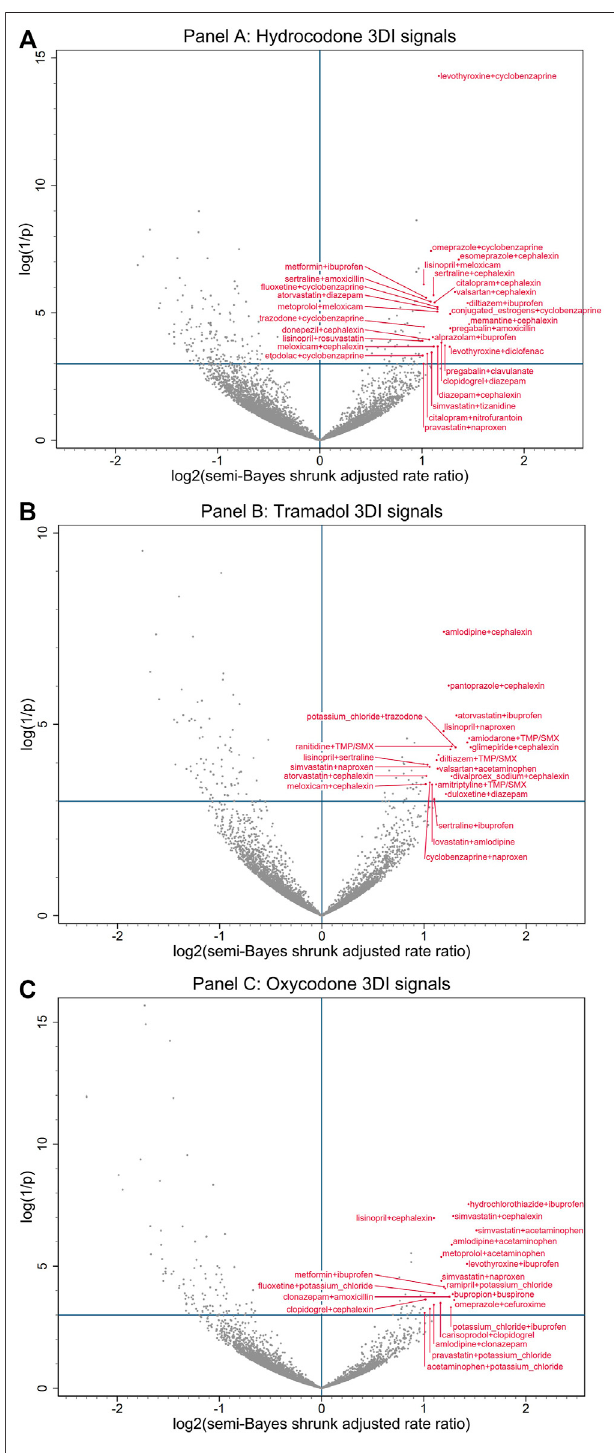
FIGURE 2 | Commonly prescribed opioid + precipitant base pair with candidate interacting precipitant associations with unintentional traumatic injury. (A) depicts associations with hydrocodone. (B) depicts associations with tramadol. (C) depicts associations with oxycodone. Semi-Bayes shrinkage prespeci fi ed a variance of 0.25, assuming that 95% of true rate